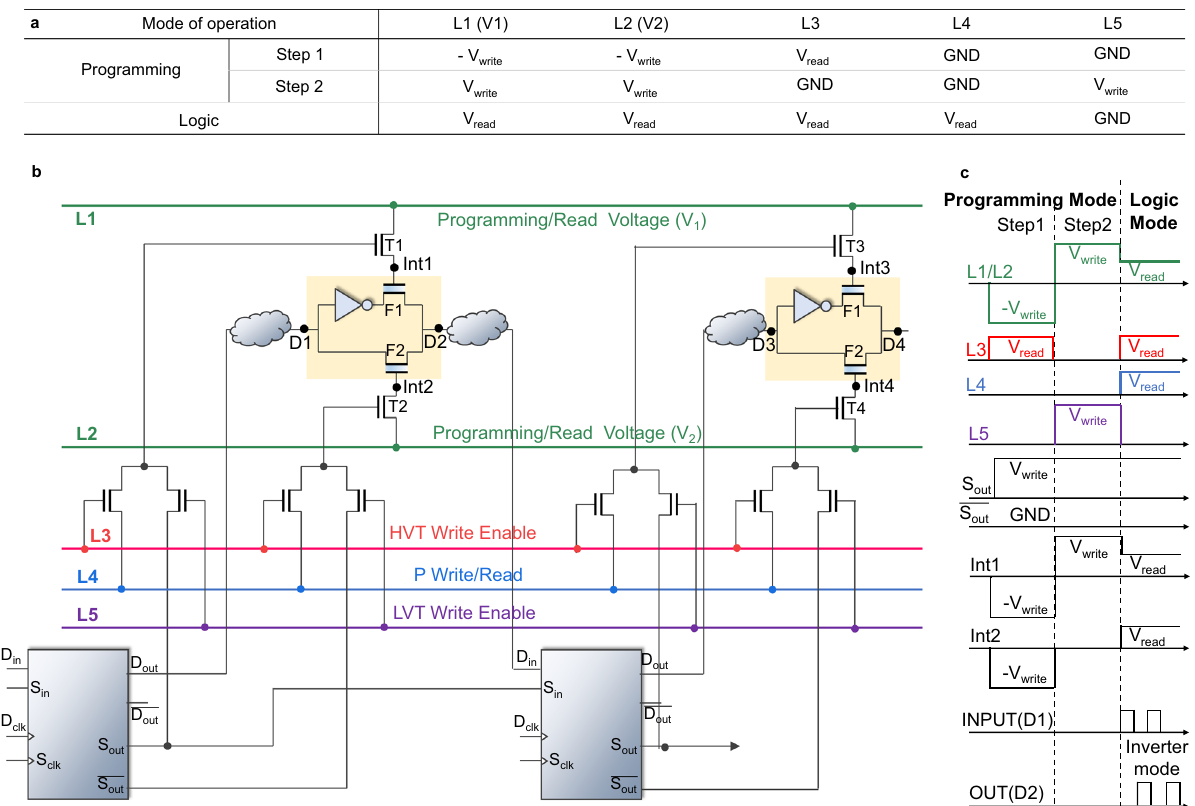
Fig. 4 Circuit description of the proposed encryption key distribution utilizing the existing data-scan fl ip fl ops in the IC. Gray bubbles indicates the functional logic. The circuits in the yellow enclosure show encryption logic. a The biasing scheme for the proposed peripheral scheme. b Schematic of the proposed encrypted IC with suggested peripheral circuitry by resusing the scan chain for the key distribution toward encryption blocks. c Peripheral biasing waveforms in the programming and logic mode operation. Note, To minimize the routing lines and periphery required, most of the metal lines are shared temporally in the